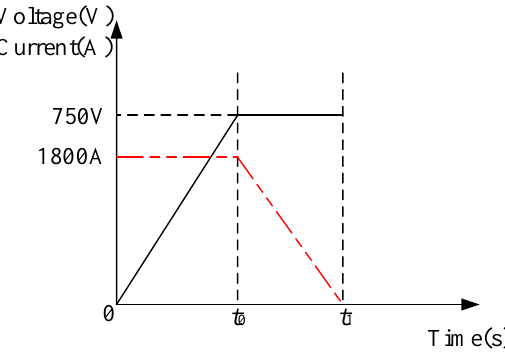
Figure 6. Supercapacitor charging curve.